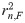
A combined ERBB-broadband and ERP-voltage projection feature space for classification (subject 5).
(A) Two cortical sites (orange and green dots) are examined. (B) The axes show the rn,F2 (blue asterisk) and rn,H2 (pink box) for ERP-voltage training projections show that these orange and green sites are highly selective during the training period (from first cross-fold). (C)
rn2 for ERBB-Broadband training projections. (D) Averaged face and house ERP templates from the green site are shown on the left axes (olive green). The face-ERP templates are projected into the raw voltage trace (black) to obtain continuous a projection weight trace (olive green trace). (E) As in (D), but for ERBB-broadband templates in the green electrode site (neon green). (F&G) As in (D&E), except for the orange electrode site in (A), using house ERP (brown) and ERBB (burned orange) templates. (H) Green electrode, face ERP vs ERBB subspace projections. (I) Orange electrode house ERP vs ERBB subspace projections. (J) ERBB projection subspace (orange-electrode house-template projection vs green-electrode face-template projection). (K) As in (J), for ERP projection subspace. (L) A 3-d subspace projection (features from D,E,G). (M) Posterior probability of a face, Pr{Γm(t)|q → F} (blue), or house stimulus, Pr{Γm(t)|q → F} (pink), having been presented (where m → ERP, ERBB or both features for the projection space).